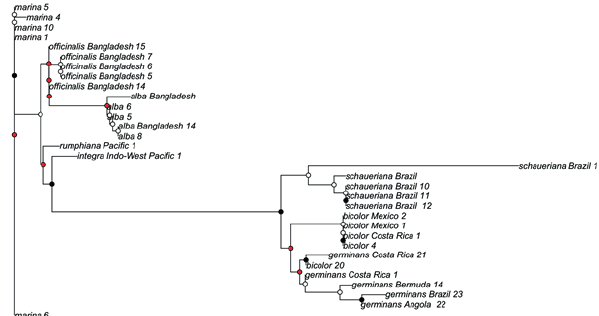
Figure 9. Monophyly test of the studied Avicennia species based on ITS sequences. a The red circles on the. nodes indicate a significant monophyletic clade.